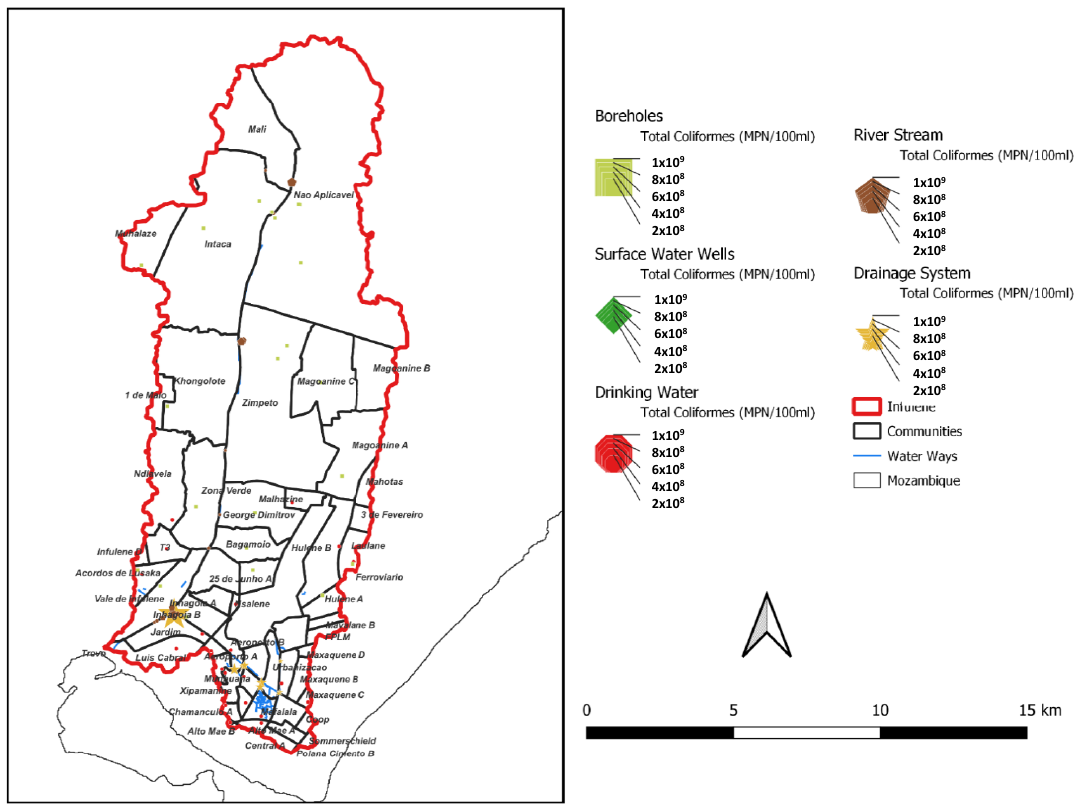
Figure 7. Spatial analysis of concentration of TC within the Infulene River Basin, considering both (1) the river water, drainage water; and (2) drinking water .